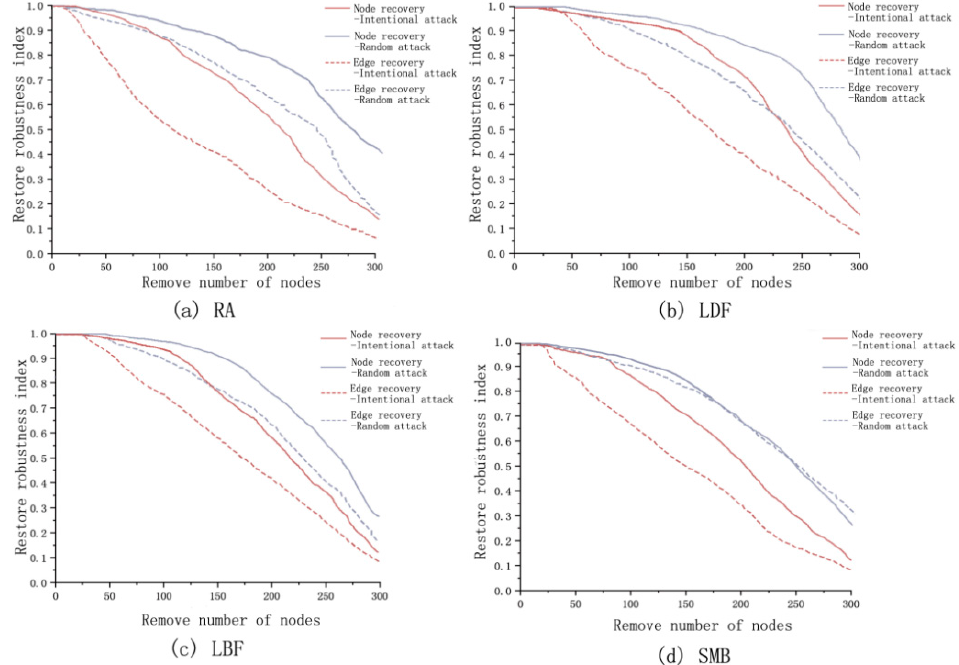
Figure 9. Recovery robustness analysis of ecological network with different optimization strategies: ( a ) recovery robustness analysis of ecological network under RA; ( b ) recovery robustness analysis of ecological network under LDF; ( c ) recovery robustness analysis of ecological network under LBF; ( d ) recovery robustness analysis of ecological network under SMB.